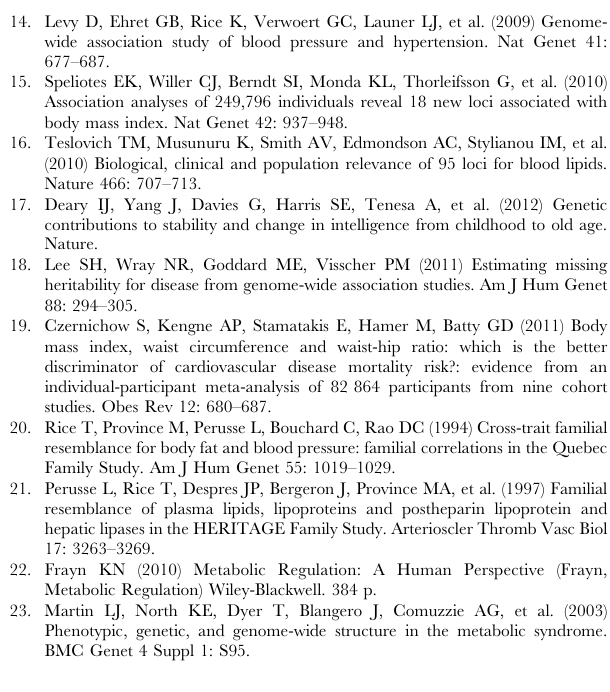
error of genetic (upper triangle) and residual (lower triangle) covariance estimates from the univariate (diagonals) and bivariate (off-diagonals) REML model. Table S4 Genetic and residual covariance estimates for the ARIC population among unrelated individuals. Mean and standard error of genetic (upper triangle) and residual (lower triangle) covariance estimates from the univariate (diagonals) and bivariate (off-diagonals) REML model. Table S5 Genetic (upper triangle) and residual (lower triangle) correlations among unrelated individuals in the ARIC population based on simultaneous analysis of all MetS traits. Mean and standard error of the Pearson correlation coefficient for genetic correlations (upper triangle) and residual correlations (lower triangle). An asterisk indicates significance with p , 0.05 adjusted for 21 hypotheses using the two-tailed hypothesis test and normal distribution of the Fisher transformed correlation coefficient. Table S6 Genetic (upper triangle) and residual (lower triangle) covariances among unrelated individuals in the ARIC population based on simultaneous analysis of all MetS traits. Mean and standard